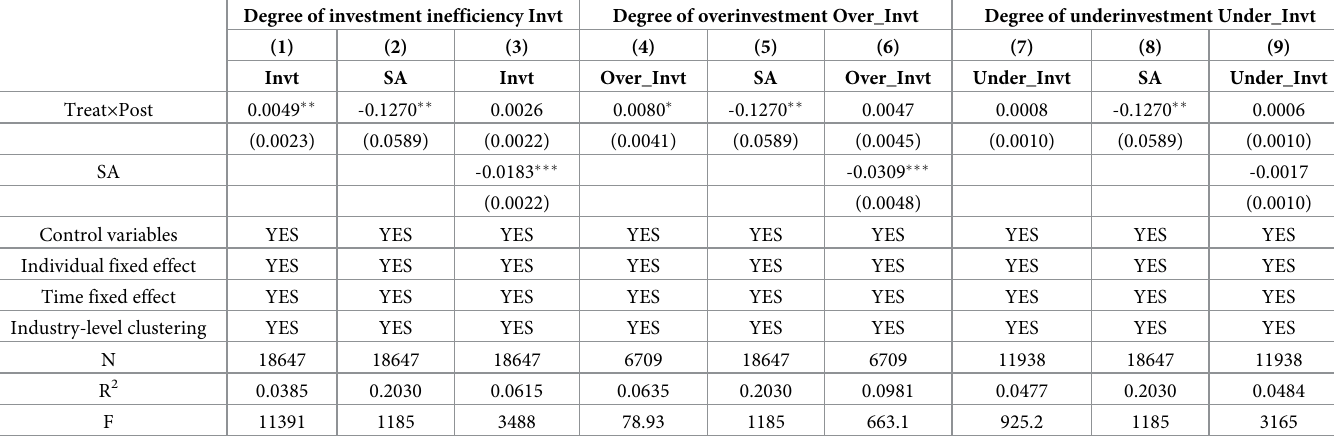
Table 7. Mechanism test results. Degree of investment inefficiency